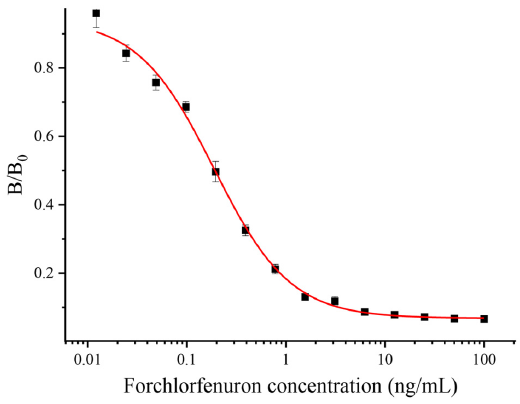
Figure 3. Ic-ELISA curve of the 9G9 mAb. Table 2. Comparison with previously reported (same hapten structure) IC 50 of anti-CPPU antibodies.